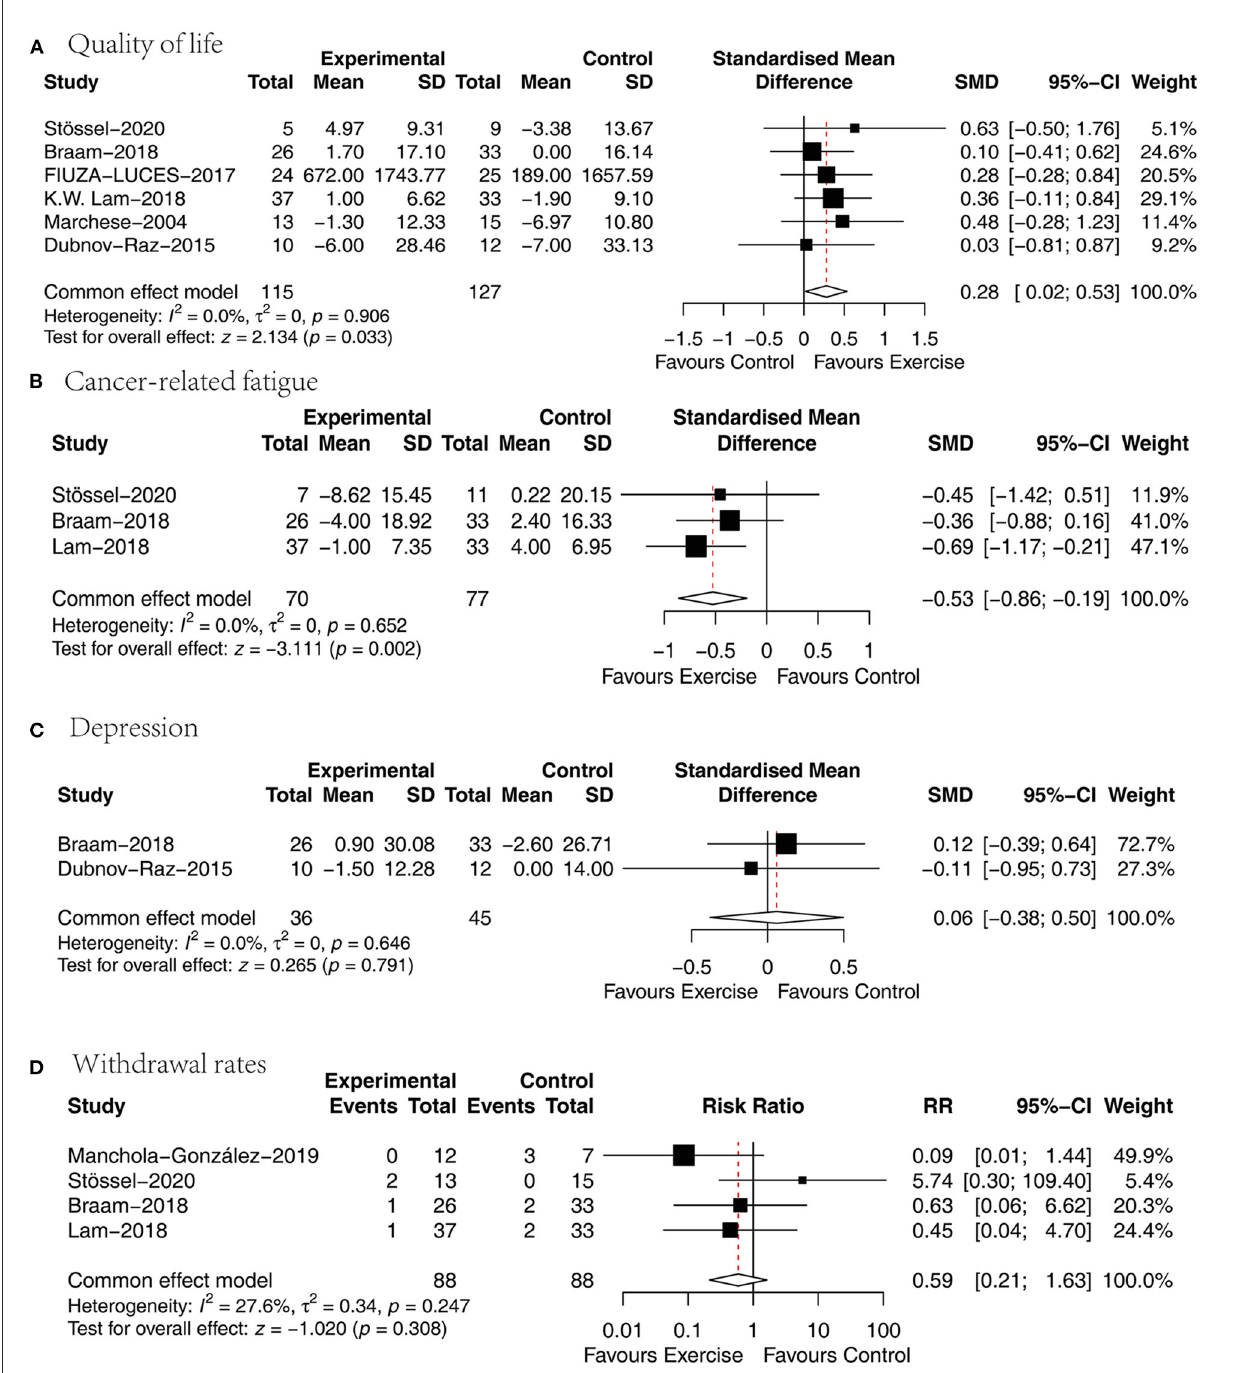
FIGURE5 Results of meta-analysis of (A) quality of life, (B) cancer-related fatigue, (C) depression, (D) withdrawal rates.